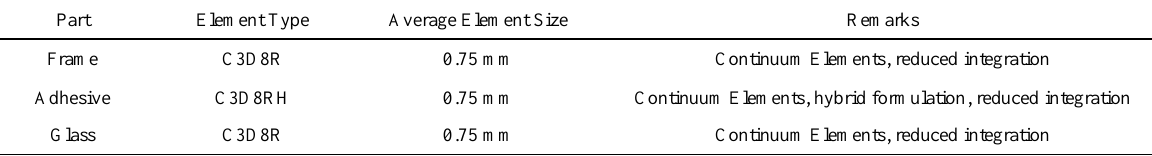
Table 4: Used Element Types and Sizes for the Global Model (ref. to (Dassault Systemes Simulia Corp.